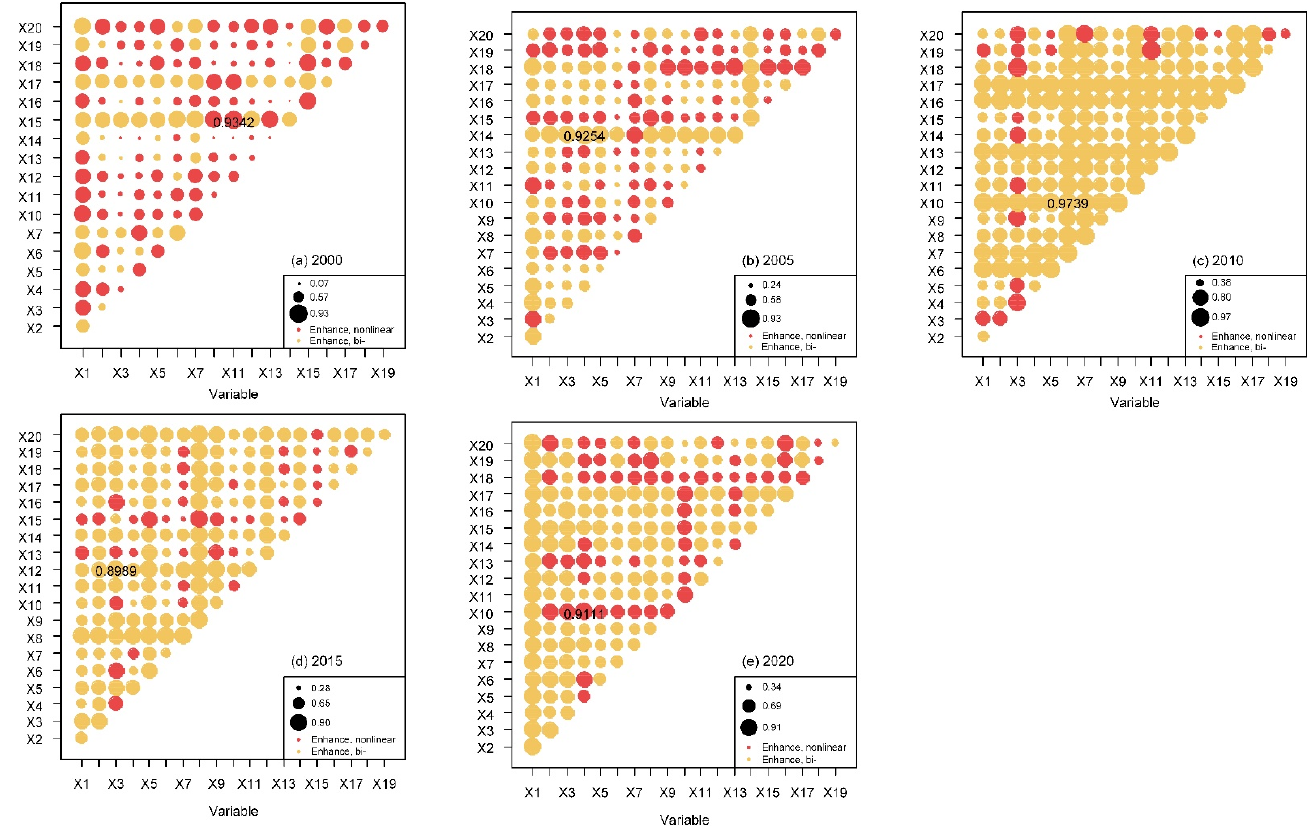
Figure 9. Interaction detection of influencing factors of URID level in HBUA from 2000 to 2020. The interaction with the highest Q value in each year is marked. The size of the dots represents the Q value of the interaction between two variables. The different colors indicate the interaction types of each two variables (Table 3). The variables X8 and X9 in 2000 were excluded because their variances both were 0.